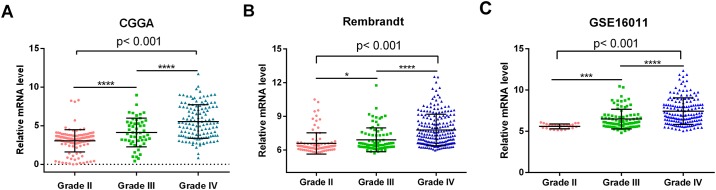
MMP9 expression was correlated with glioma grade.(A) MMP9 expression was correlated with glioma grade (p<0.001). Glioma of grade IV showed a significantly increased in MMP9 expression compared to grade II and III gliomas (p<0.0001, p<0.0001, respectively). MMP9 expression level in grade III gliomas was markedly higher than that in grade II gliomas (p<0.0001). (B, C) Likelihood ratio test showed that MMP9 was significantly associated with tumor grade in two independent glioma dataset (p<0.001, p<0.001, respectively) * p< 0.05; **** p<0.0001.